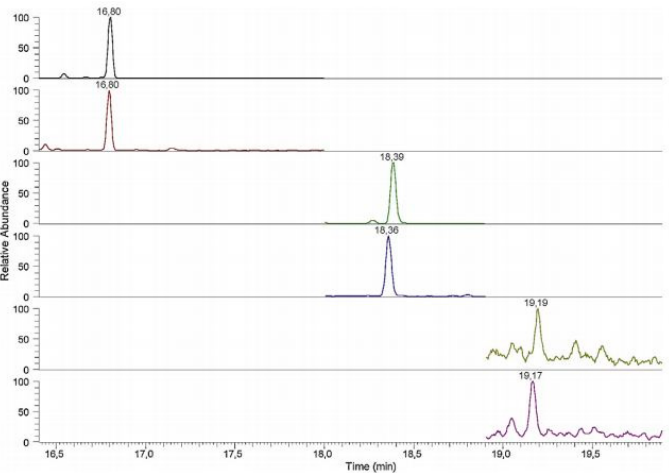
Figure 9. SPME-GC-QqQ-MS (SRM acquisition mode) chromatogram of a real urine sample from an healthy individual (retention times: 16.80 DA: 16.80 DA-d3; 18.39 5-HT: 18.36 5-HT-d4: 19.19 NE: 19.17 ME-d6). Figure adopted from reference [74] with the copyright permission.